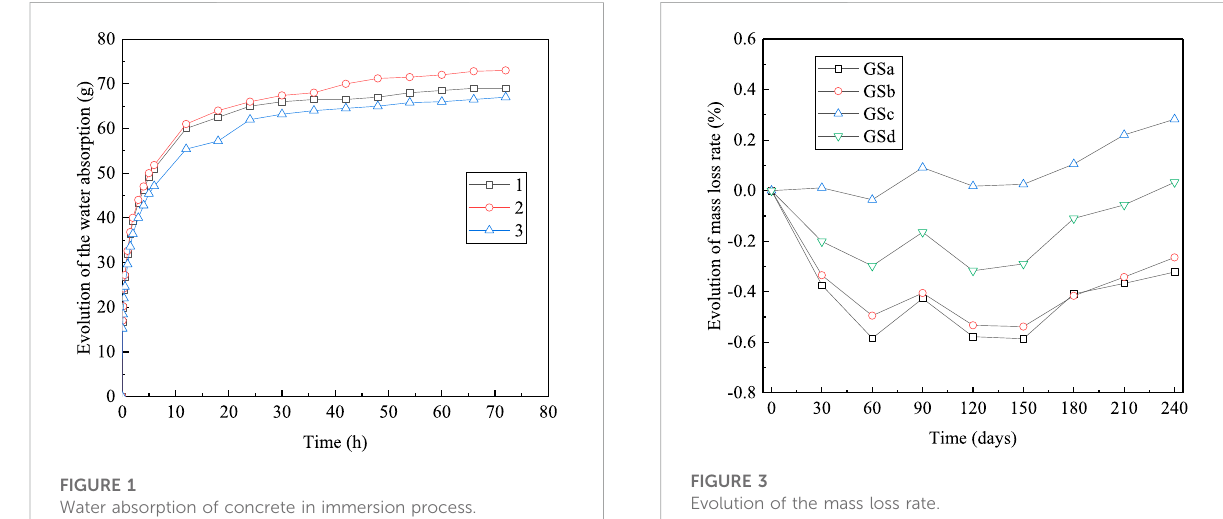
FIGURE 3 Evolution of the mass loss